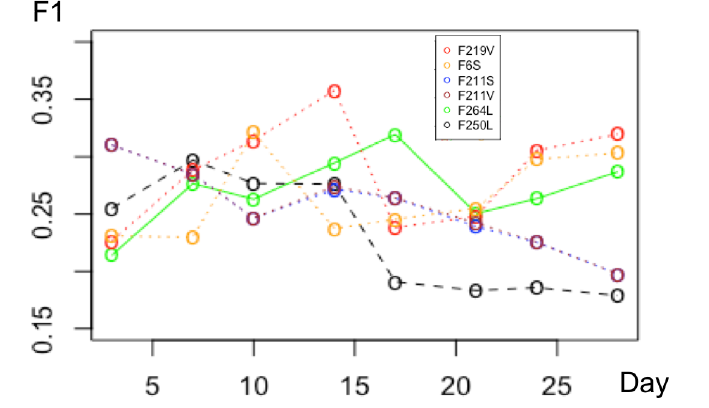
Figure 1. Average F1 Scores by Signal using Different Running